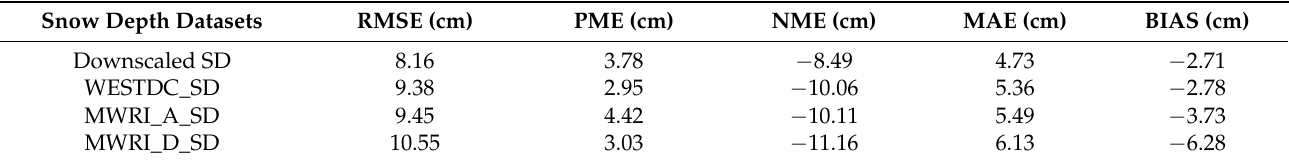
Table 3. The root mean square error (RMSE), positive mean error (PME), negative mean error (NME), average absolute error (MAE) and bias (BIAS) for four types of snow depth (SD) dataset for NX base ground stations. Snow Depth Datasets RMSE (cm) PME (cm) NME (cm) MAE (cm) BIAS (cm) Downscaled SD 8.16 WESTDC_SD